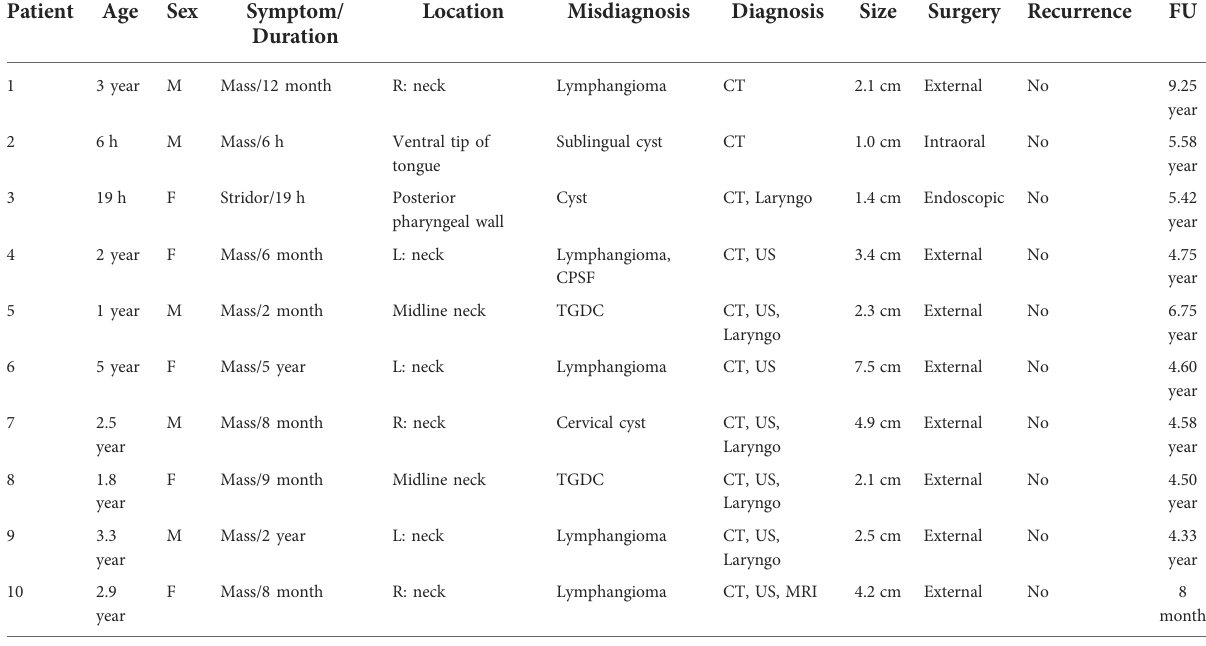
TABLE 1 Clinical summary of head and neck